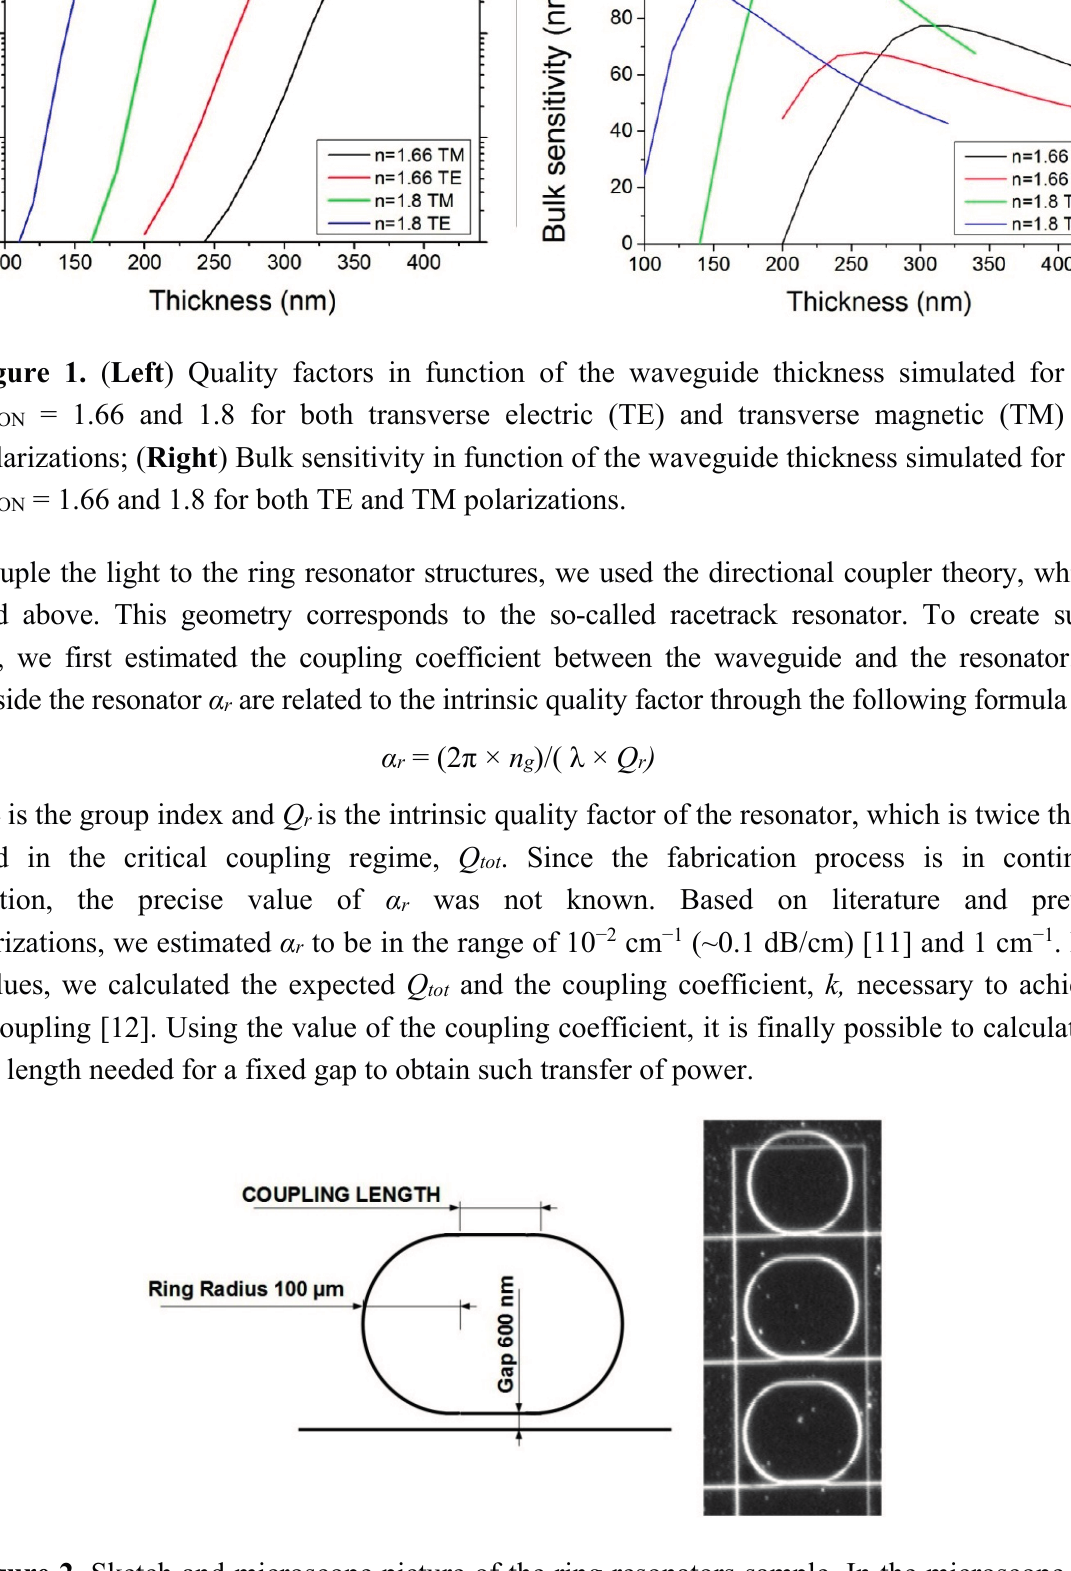
Figure 2. Sketch and microscope picture of the ring resonators sample. In the microscope image, we can clearly observe the etching windows around the resonators that allow the functionalization of the